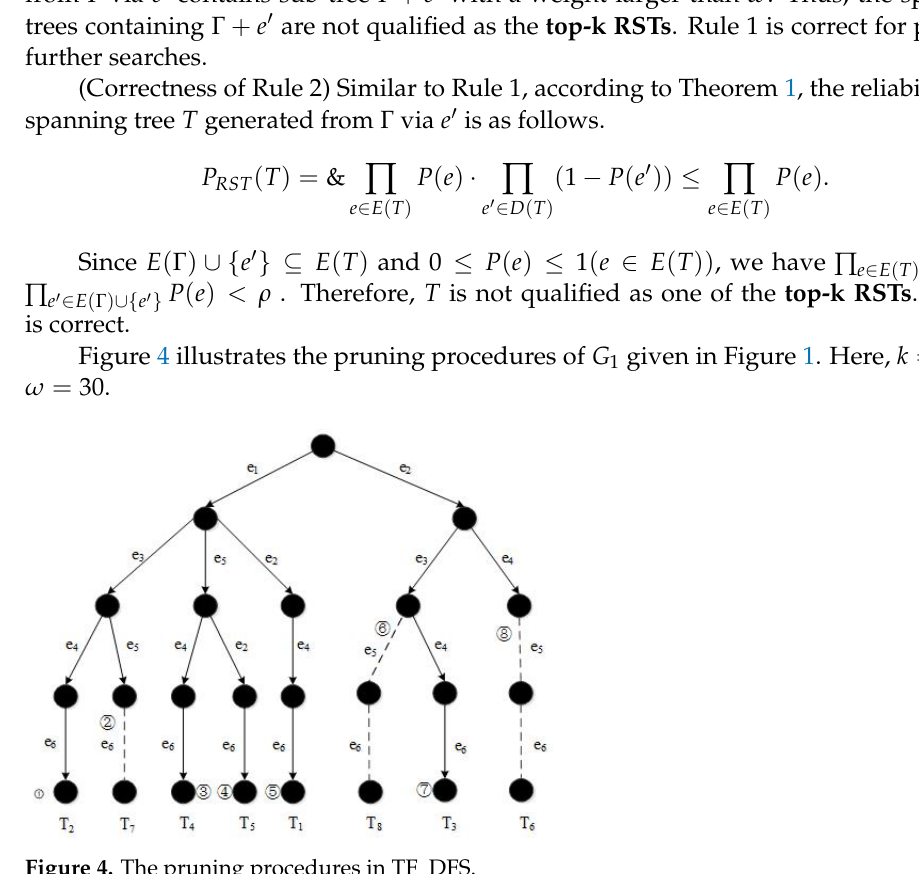
Algorithm 2 provides the pseudo codes for the DFS based tree-filtering